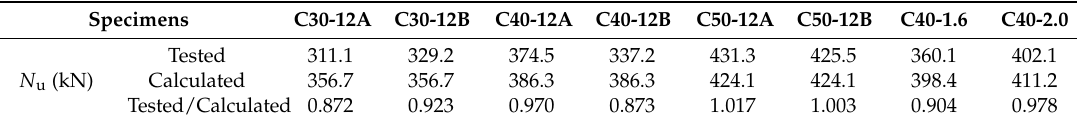
Table 10. The tested and calculated ultimate force of the test